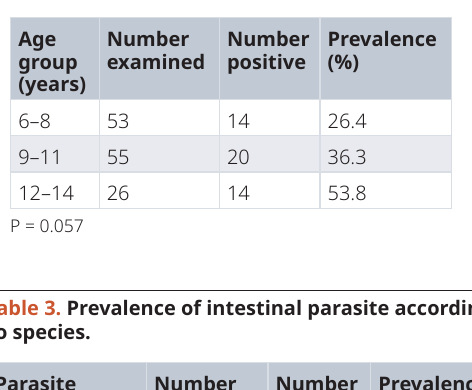
Table 2. Prevalence of intestinal parasite according to age group.